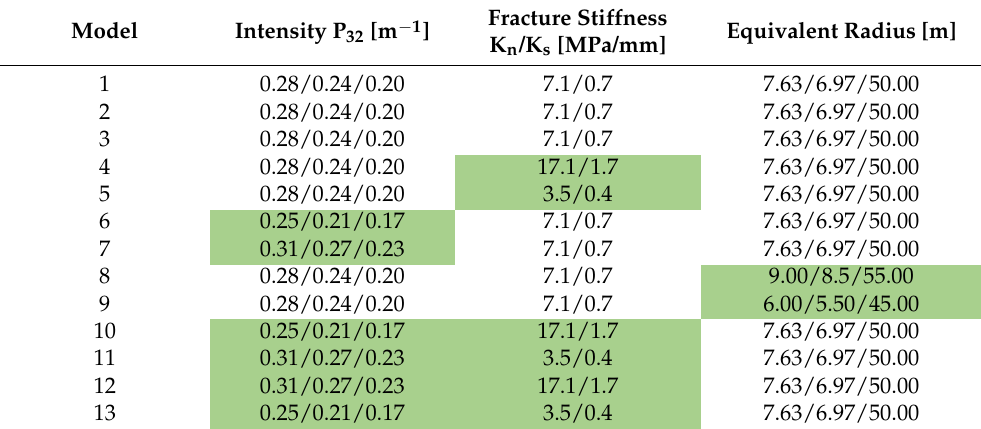
Figure 5. Sensitivity analysis for ( a ) the rock mass strength and ( b ) the deformation modulus depending on the lattice resolution for the Remlingen sandstone. The dotted black line marks the adopted lattice resolution of 110 cm. Table 4. Input parameters of the sensitivity analysis for the DFN properties of the LS-SRM rock mass models. Colored boxes indicate which fracture parameter was changed.